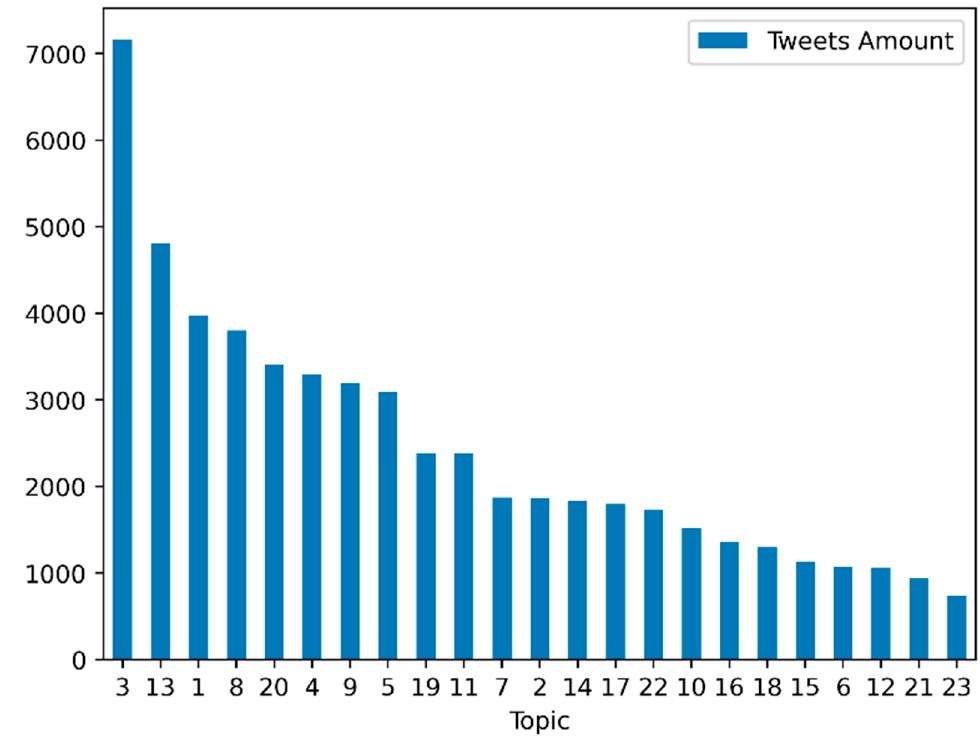
Figure 6. Tweets distributions among the 23 extracted topics.